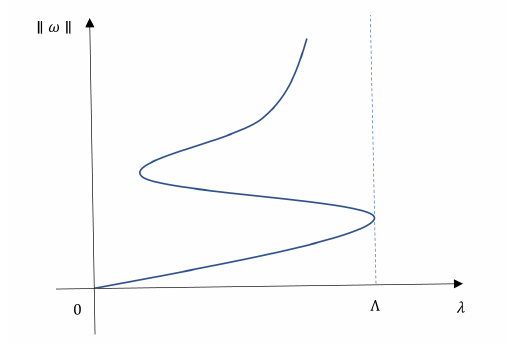
Fig. 2.1: Possible bifurcation